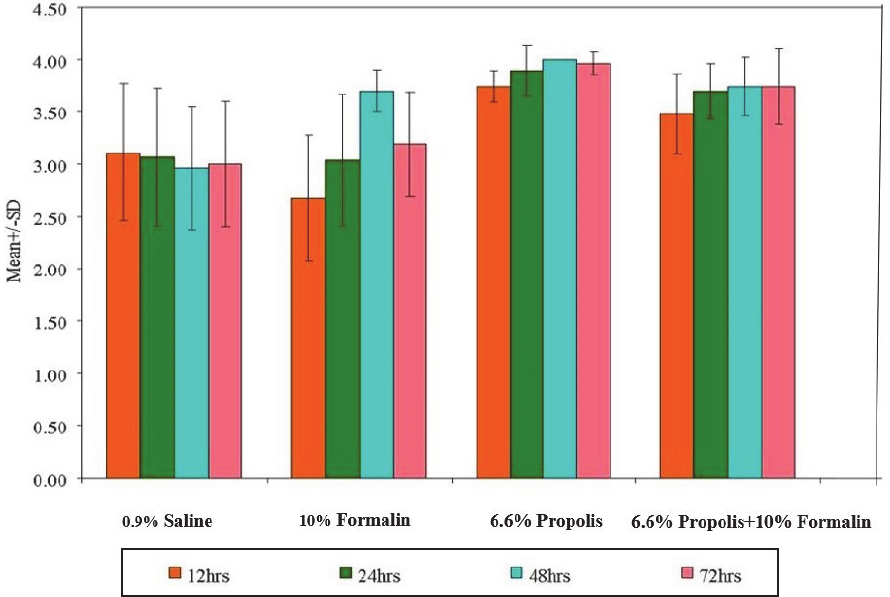
Figure 7. A graph showing within-group comparison at different time points .